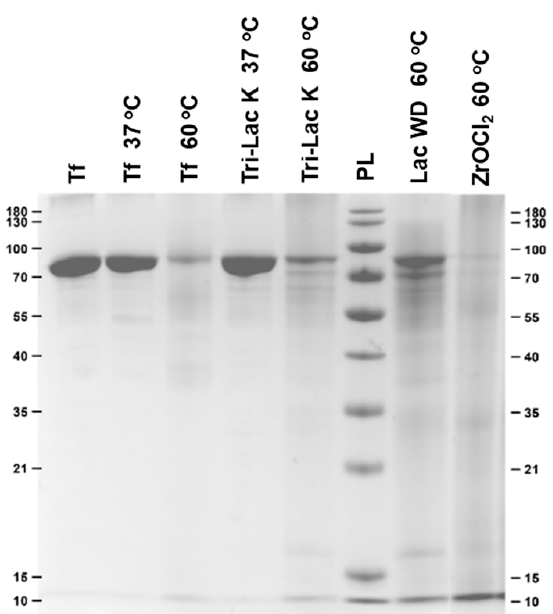
Figure 3. SDS-Page gel featuring intact transferrin (lane 1), transferrin incubated in phosphate buffer (lanes 2–3), and transferrin incubated in buffer solutions containing control samples. The samples were incubated for 7 days.